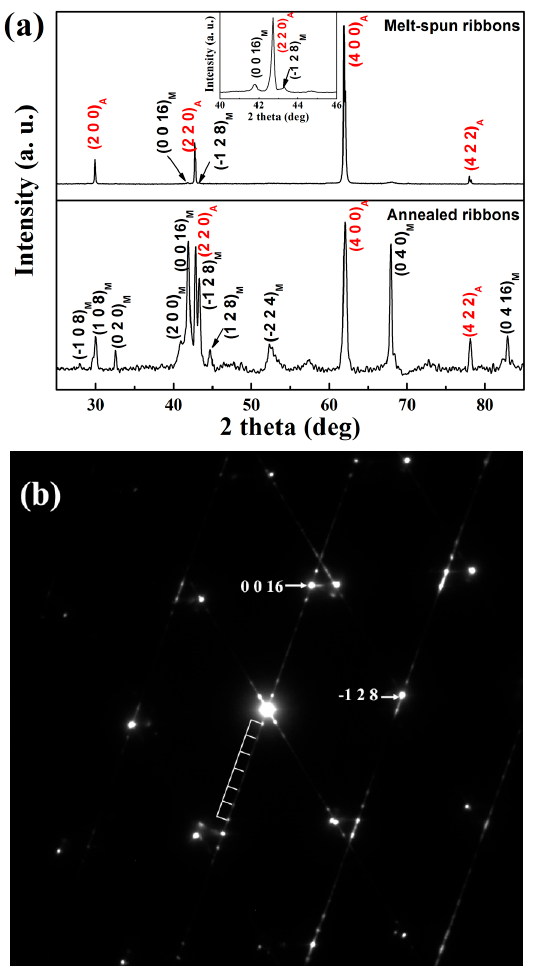
Figure 2. ( a ) X-ray diffraction patterns for melt-spun and annealed ribbons. ( b ) Selected area electronic diffraction (SAED) pattern for the martensite of melt-spun ribbons along <2 1 0> M .